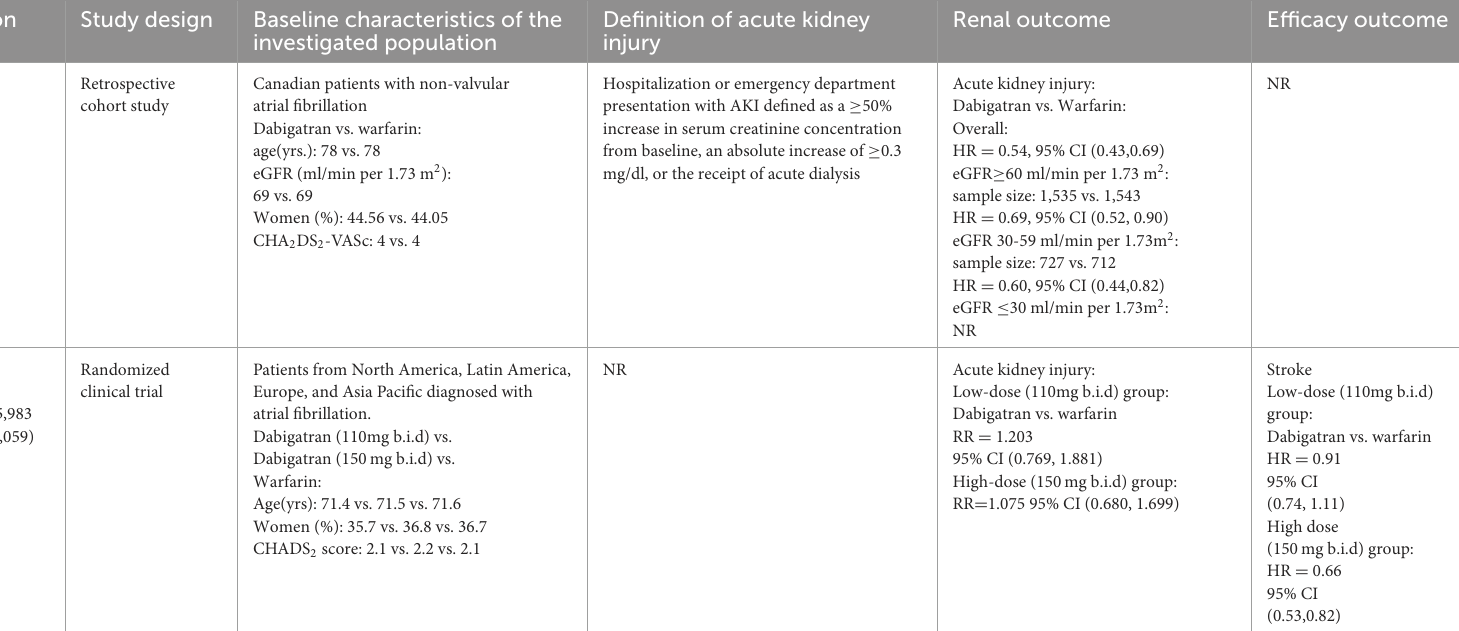
Acute kidney injury: Dabigatran vs. Warfarin: Overall: HR = 0.54, 95% CI (0.43,0.69)